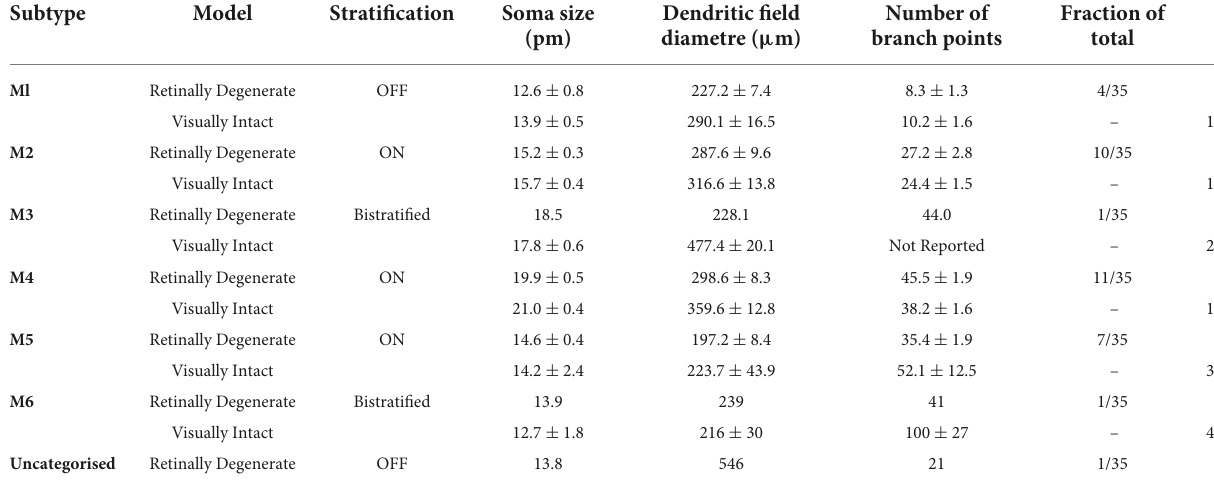
TABLE 1 Quantitative morphological analysis of ipRGCs in the Opn4 Cre / + ; rd/rd mouse using BRIAN. (A) Population data (Mean ± SEM) for stratification, soma size, dendritic field diameter and total number of branch points for the six reported ipRGC subtypes identified from four Opn4 Cre / + ; rd/rd retinas using the BRIAN platform. Single cell data was collected using the commercially available plug-in Filament Tracer (IMARIS, Bitplane). Visually intact data collected from published literature on Opn4 Cre / + mice and previously